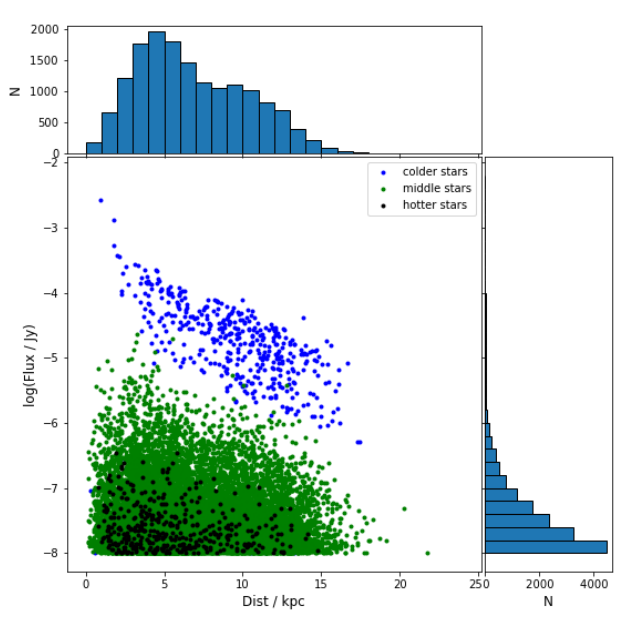
Figure 5. The distribution of distance and estimated fluxes of detectable OB stars. The upper panel is for the distance, while the right is for the flux. The middle panel shows how the flux varies with distance. Black and green dots represent sources applied with Equations (4) and (5), respectively. Blue dots are sources with a temperature lower than 12,500 K.The flux gap in Figure 5 rises from the bigger constant ( − 5.99) used in Equation